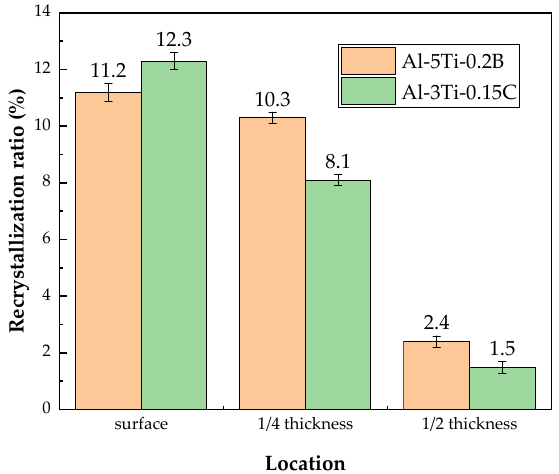
Figure 11. Fracture path for 7050 ingot with different grain refiners: ( a ) Al ‐ 3Ti ‐ 0.15C ( b ) Al ‐ 5Ti ‐ 0.2B. As discussed in Section 2, the recrystallization ratio is one of the factors affecting fracture toughness: the higher the recrystallization fraction, the lower the fracture tough- ness. The recrystallization ratio of the 7050-T7651 plate in different thickness positions with Al-5Ti-0.2B and Al-3Ti-0.15C grain refiners are shown in Figure 12. From surface to 1/2 thickness, the recrystallization ratio for the 7050 plate with Al-5Ti-0.2B grain refiner is 11.2%, 10.3%, and 2.4%, respectively, and 12.3%, 8.1%, and 1.5% with Al-5Ti-0.2B grain refiner. There are no obvious differences in the recrystallization ratio for the 7050-T7651 plate with different grain refiners.